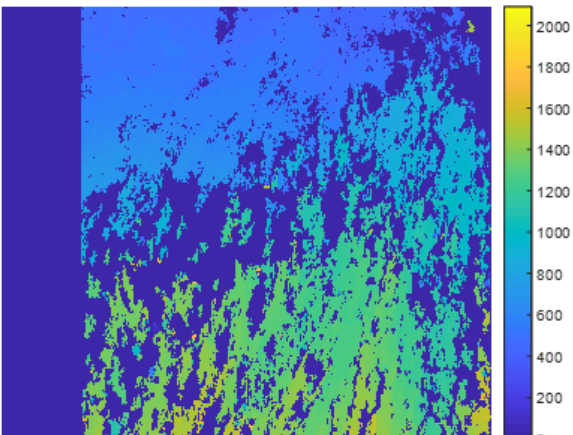
Figure 8. Binocular-corrected image.